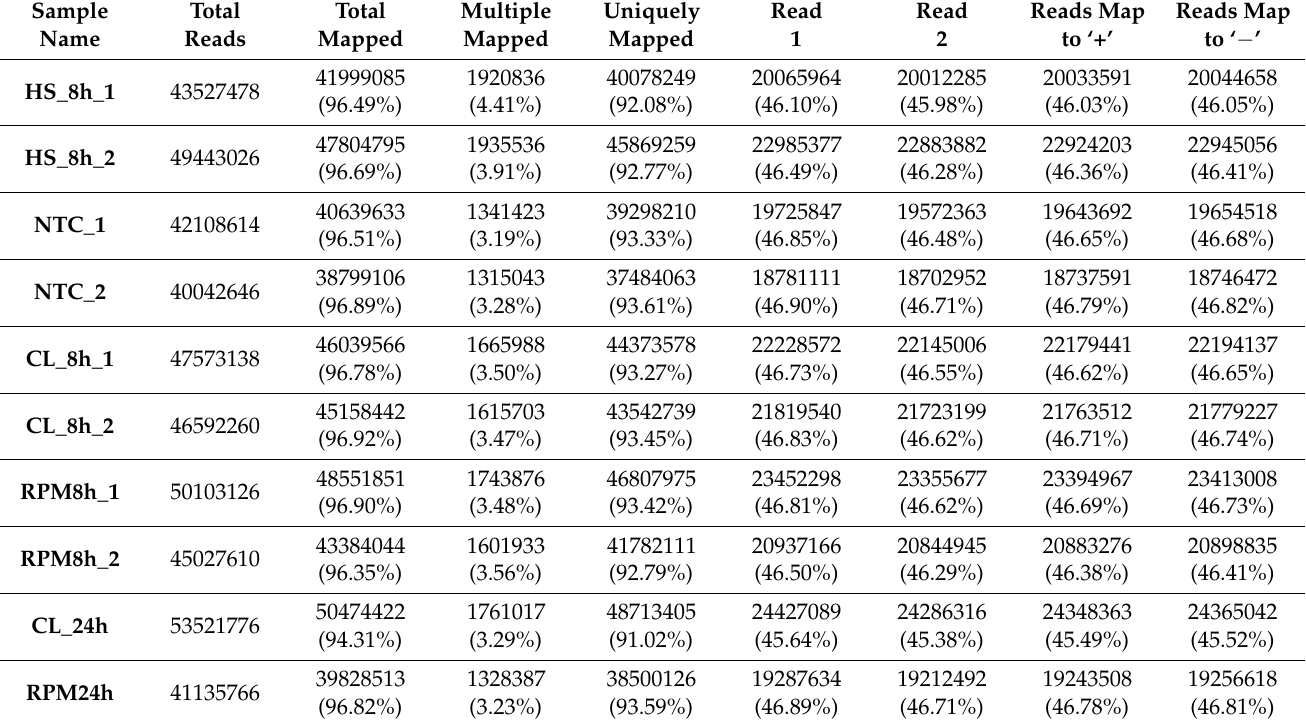
Table A6. Overview of RNA-seq data Mapping